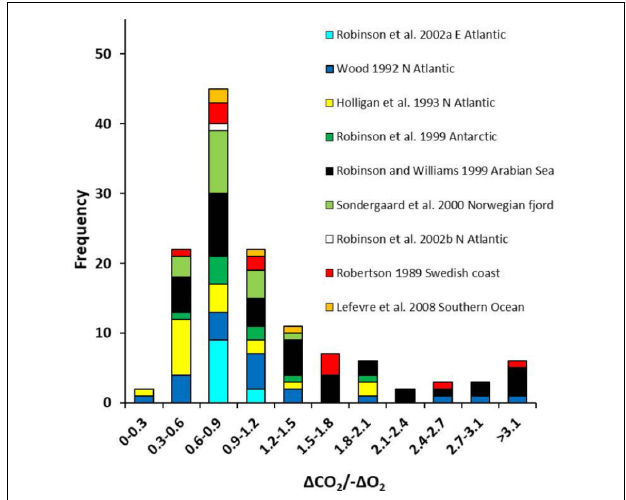
FIGURE 2 | Frequency histogram of apparent respiratory quotients (the ratio of oxygen consumption to production of dissolved inorganic